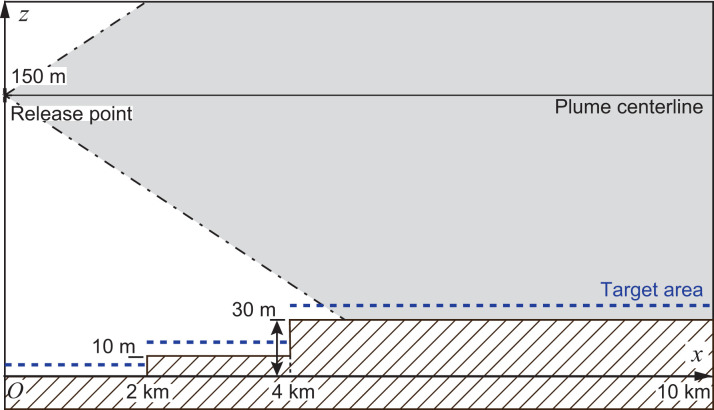
Schematic of a cross-sectional view for the elevated terrain modeled for case 1C.The dashed line indicates the target cells set at 1 m above the ground.